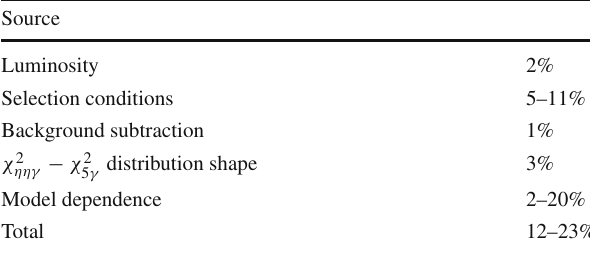
Table2 Themainsourcesofthesystematicuncertaintyinthemeasured e + e − → ηηγ cross